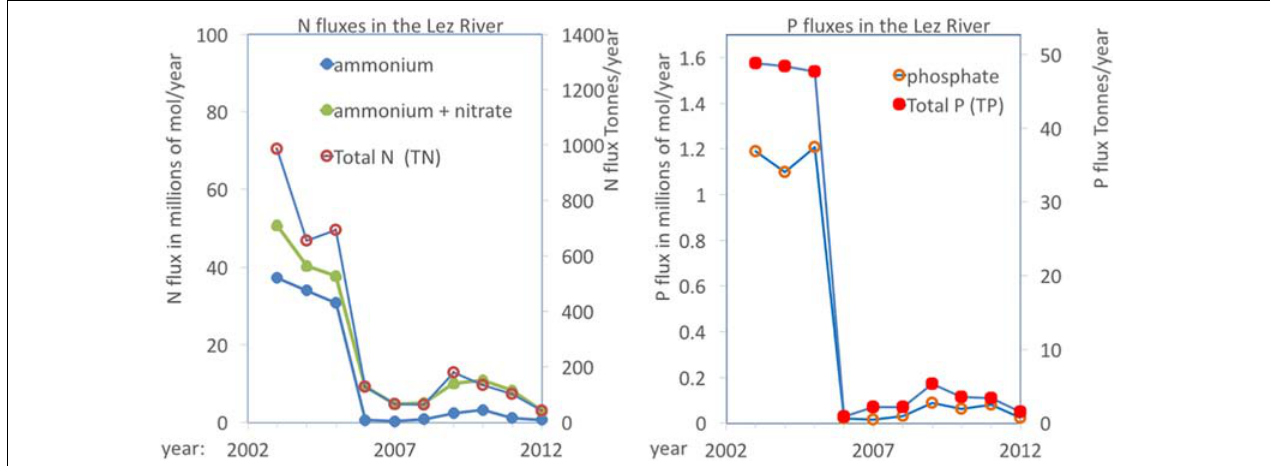
FIGURE 5 | Annual fluxes of N and P compounds in the Lez River. Values can be read on both scales (left in millions of mols/year; right in metric tonnes/year for N and P, respectively). Source: “Banque Hydro” and “Naïade” (réseau de données eaufrance, DCE).